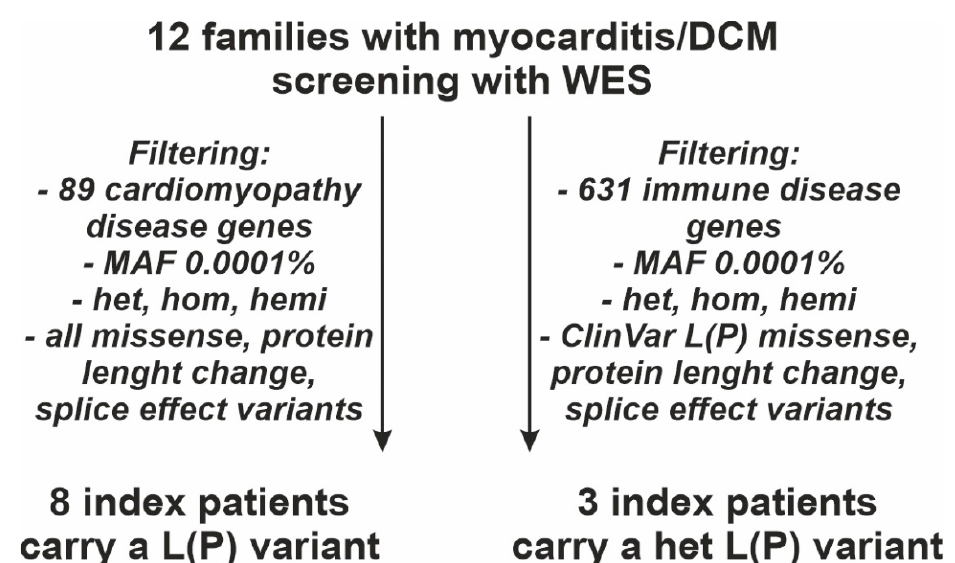
Figure 1. Study flow chart of the genetic evaluation after whole-exome sequencing (WES), including only patients with biopsy-proven myocarditis and phenotype of dilated cardiomyopathy (DCM). Cardiomyopathy (CMP) disease genes and immune disease genes were filtered with minor allele frequency (MAF) of 10 − 4 for pathogenic and likely pathogenic, L(P), variants. Filtering for cardio- myopathy and immune disease genes included all heterozygous (het), homozygous (hom), and hemizygous (hemi) variants. Analysis of cardiomyopathy disease genes included all missense, pro- tein length changing, and splice effect variants. Analysis of immune disease genes included all pro- tein length changing and splice effect variants, but only missense L(P) variants previously annotated in ClinVar.